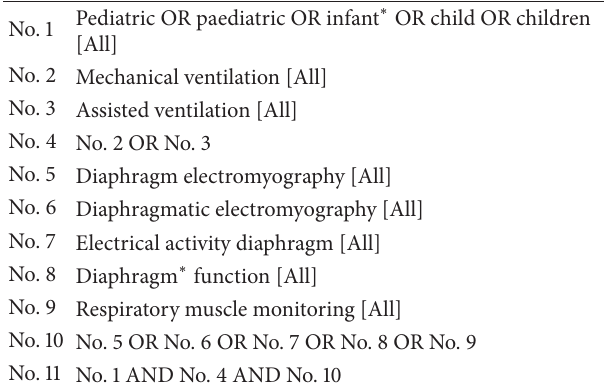
Table 1: Search strategy for identifying related articles in